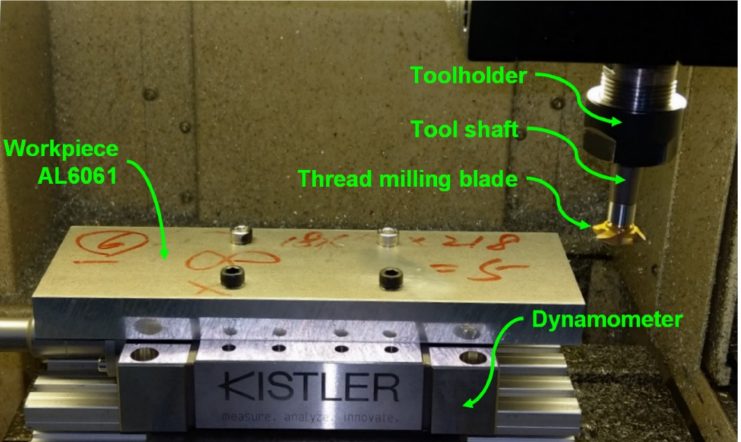
Figure 4. Experimental setup for the estimation of cutting torque using the disturbance observer